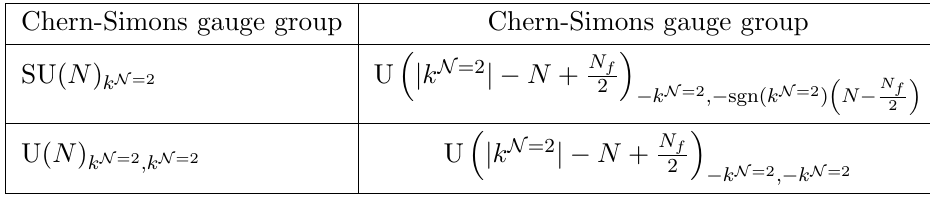
Table 2. We list the supersymmetric dualities of (E.1), (E.2). In the table, we only list the gauge group on the two sides of the duality. On both sides we have a gauge (cid:12)eld coupled to N f fundamental chiral multiplets. The dualities for opposite signs of the CS levels may be obtained by a parity transformation. These dualities hold for N f